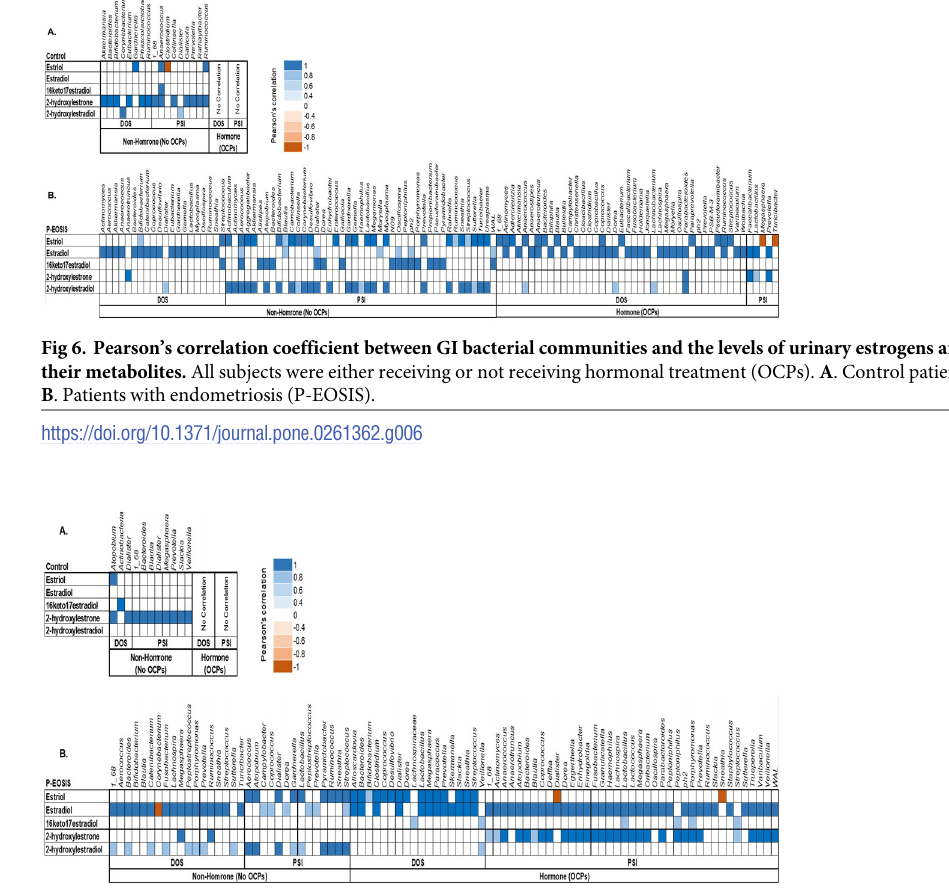
Fig 7. Pearson’s correlation coefficient between UG bacterial communities and level of urinary estrogens and its metabolites. All subjects were either receiving or not receiving hormonal treatment (OCPs). A . Control patients; B . Patients with endometriosis